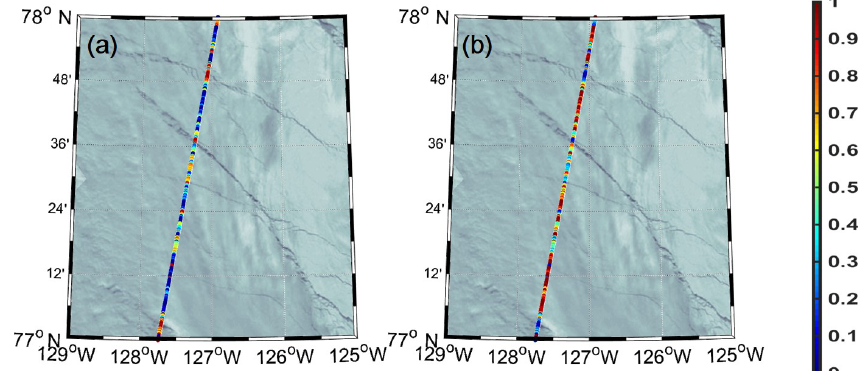
Figure 3. Lead and ice abundance derived by the waveform mixture algorithm on 10 October 2015. (a) Lead abundance, (b) ice abundance. The color bar expresses abundances from 0 to 1.